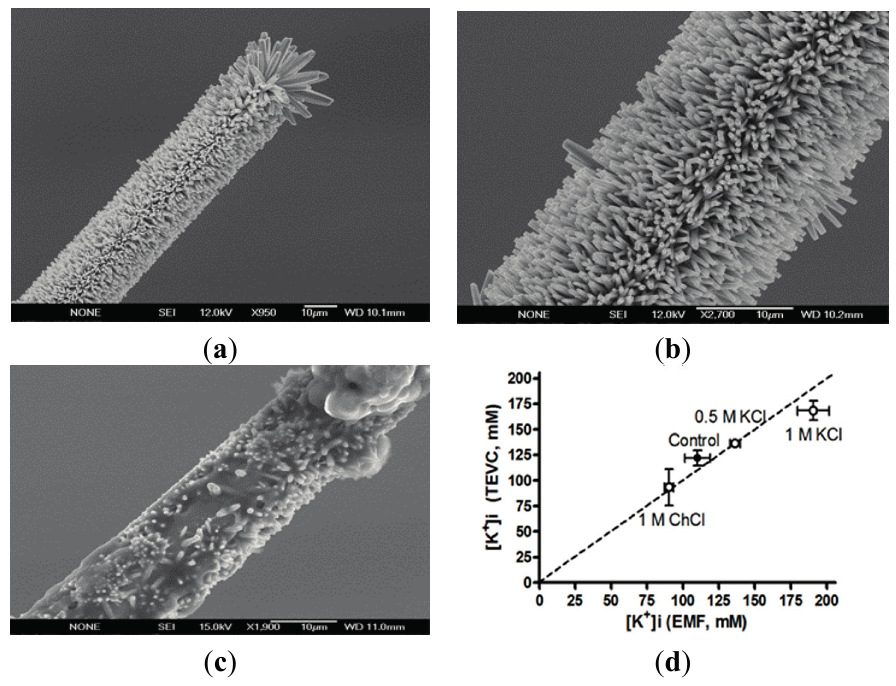
Figure 12. Intracellular K + concentrations in Kv channel-expressing Xenopus oocytes measured with electrophysiological and K + -selective microelectrode methods. The Field emission scanning electron microscopy images of the K + -selective microelectrode before ( a , b ) and after intracellular measurements ( c ). Data points are expressed as mean values for control oocytes and oocytes injected with 50 nL of indicated test solution ( d ). Error bars show SE. n = 3–5)